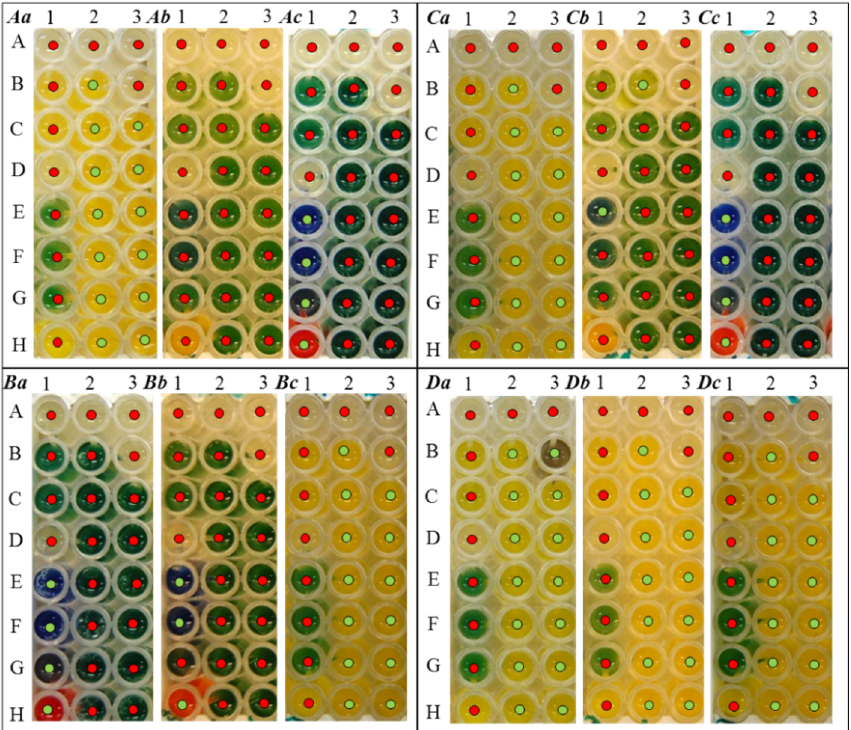
Figure 4. Biochemical properties of tested G - bacterial strains ( A ) E. coli , ( B ) P. mirabilis , ( C ) S. typhimurium and ( D ) P. aeruginosa . ( a ) without UV exposure, ( b ) after exposure to laboratory UV and ( c ) after stratospheric UV irradiation. Biochemical changes were observed by the observation of the biochemical markers of Enterobacteriaceae after 24 hours of incubation in a thermostat at 37 °C. Legend: 1A, malonate; 1B, Simmons citrate; 1C, arginine; 1D, urease; 1E, ornithine; 1F, lysine; 1G, hydrogen sulfide; 1H, indole; 2A, mannitol; 2B, trehalose; 2C, saccharose; 2D, cellobiose; 2E, adonitol; 2F, inositol; 2G, β galactosidase; 2H, phenylalanine; 3A, glucose; 3B, dulcitol; 3C, raffinose; 3D, melibiose; 3E, rhamnose; 3F, sorbitol; 3G, aesculin; 3H,